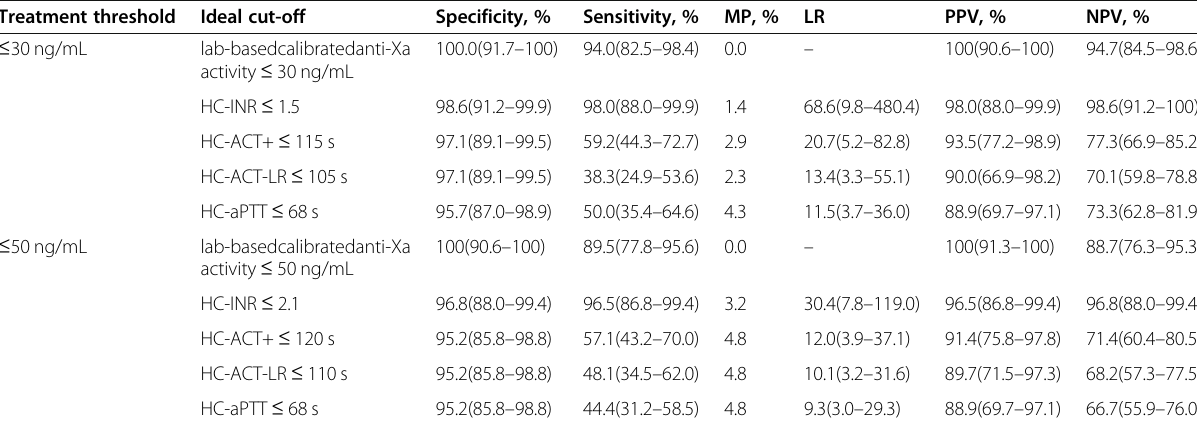
Table 2 Diagnostic accuracy of Hemochron ™ Signature Elite POCT for edoxaban Treatment threshold Ideal